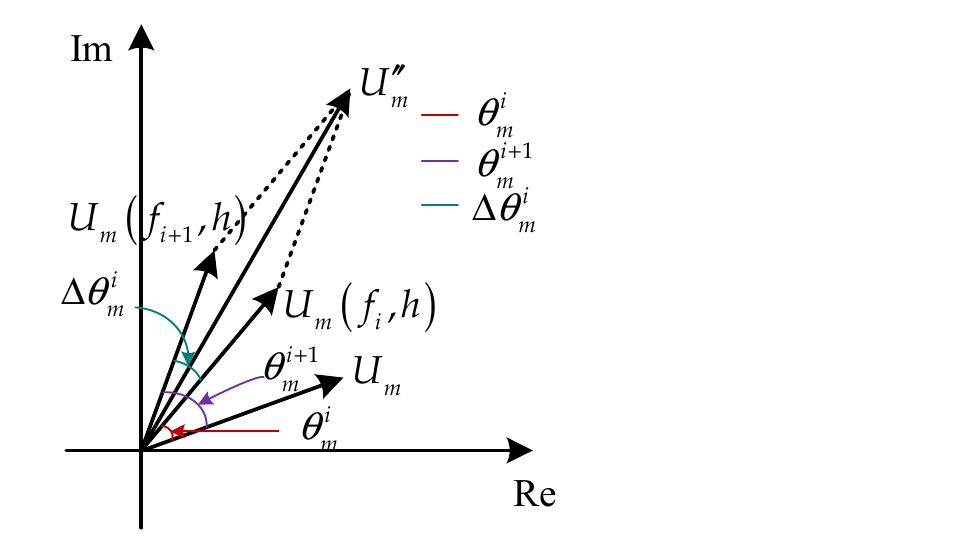
U m has the maximum amplitude as: